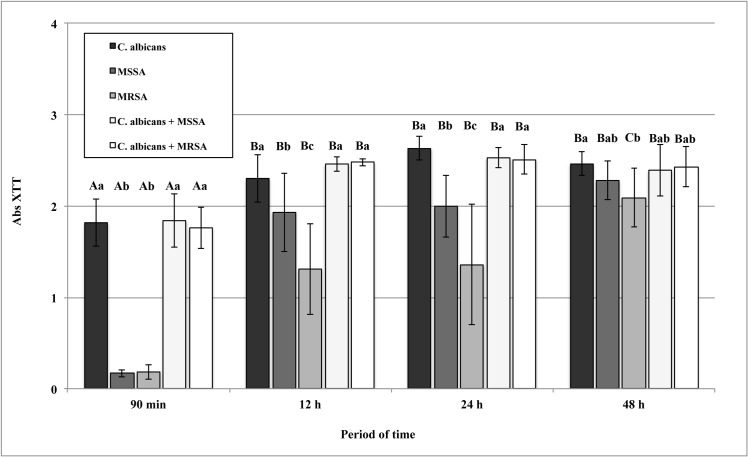
Absorbance values of XTT reduction (Abs XTT) obtained from 90 min of adhesion and biofilms of C. albicans, MSSA, and MRSA as single- and dual-species grown in RPMI at 37°C.Error bars represent standard deviation. The uppercase letters show differences among time periods and lowercase letters show differences among the growth conditions (Tukey post-hoc test at ρ>0.05).